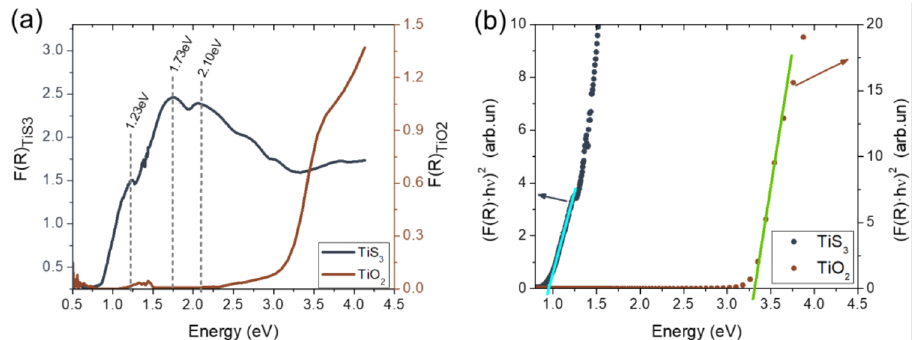
Figure 4. ( a ) Kubelka–Munk function obtained from diffuse reflectance measurements of TiS 3 (left axis) and TiO 2 (right axis). ( b ) Tauc plots of Kubelka–Munk function with the corresponding linear fit for TiS 3 (left axis) and TiO 2 (right